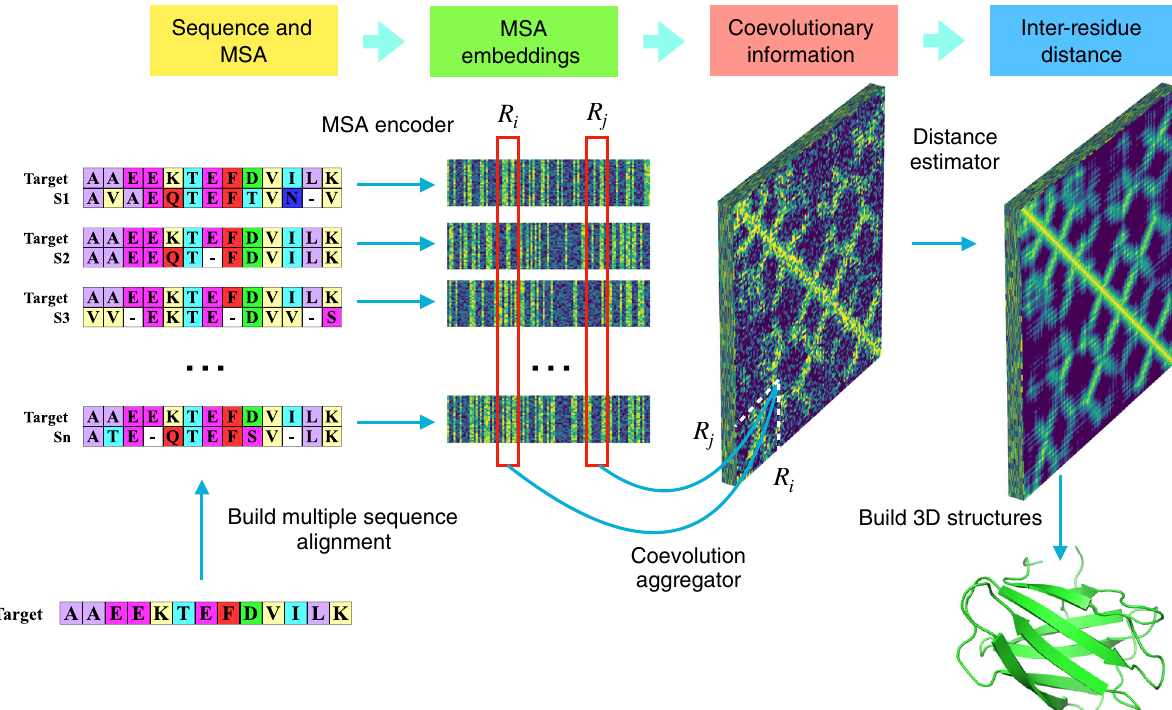
Fig. 2 Predicting protein tertiary structure using ProFOLD. Here, we use the CASP13 target protein T0992-D1 as an example to describe the main steps of ProFOLD. Only the fi rst 13 residues are shown here for the sake of clear description. First, we search this protein against sequence databases to identify its homologous proteins (2,807 proteins in total). Next, we use the acquired homologous protein to construct an MSA for this protein. Then we apply CopulaNet to infer residue co-evolution directly from the MSA. CopulaNet uses an MSA encoder to model the mutation information for each residue of the target protein, and then uses a co-evolution aggregator to measure the residue co-mutations. According to the acquired residue co-evolution information, the distance estimator estimates inter-residue distances. Finally, we transform the estimated distance distributions into a potential function, and then search for the structure conformation with the minimal potential. ProFOLD reports the structural conformation with suf fi ciently low potential as the fi nal prediction result (TMscore: For each individual alignment, MSA encoder identi fi es the mutations of each residue of the target protein, and embeds the mutations into a vector of 64 features.